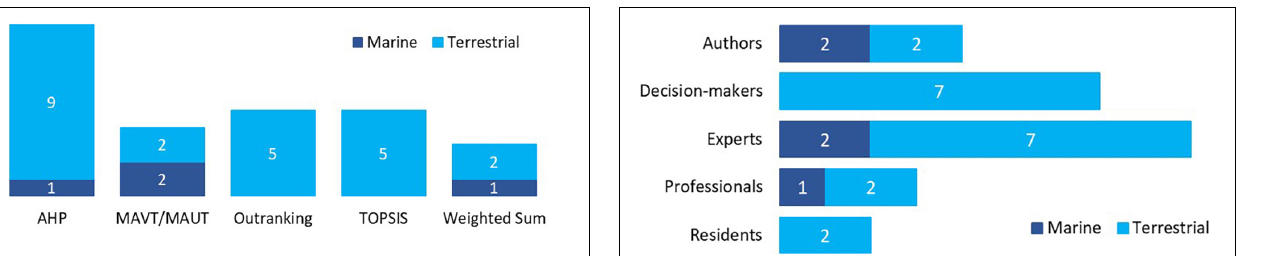
FIGURE 6 | Multi-actor weighting decisions.